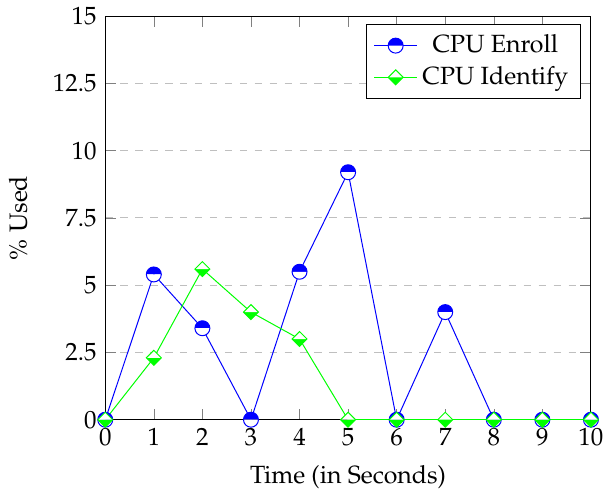
Figure 7. CPU usage when the Enroll and Identify process are called.